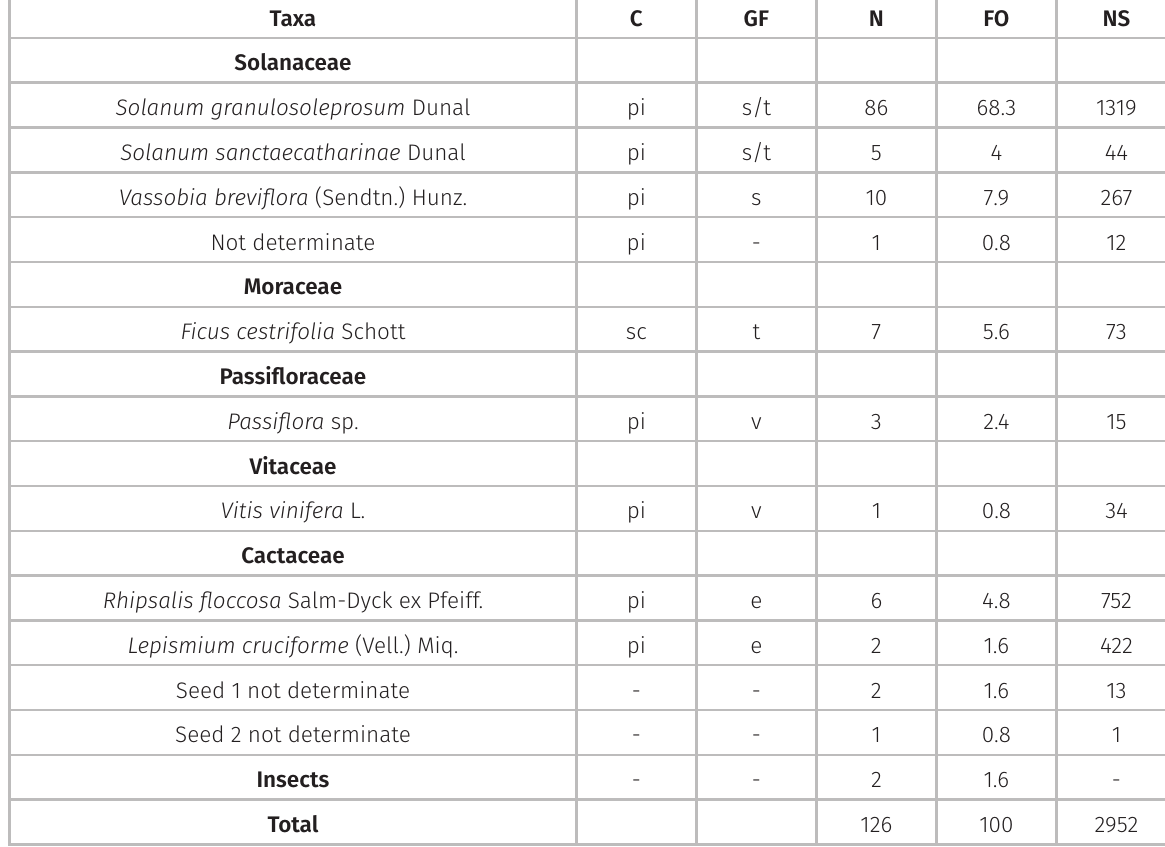
Table I. Plant species of seeds and other food item recorded in fecal samples of Sturnira lilium in Frederico Westphalen municipality, Rio Grande do Sul, Brazil. C = plant category (pi = pioneer, sc = secondary), GF = growth form (t = tree, s = shrub, e = epiphyte, v = vine), N = number of fecal samples with a given taxon, FO = frequency of occurrence in fecal samples (%), NS = total number of seeds